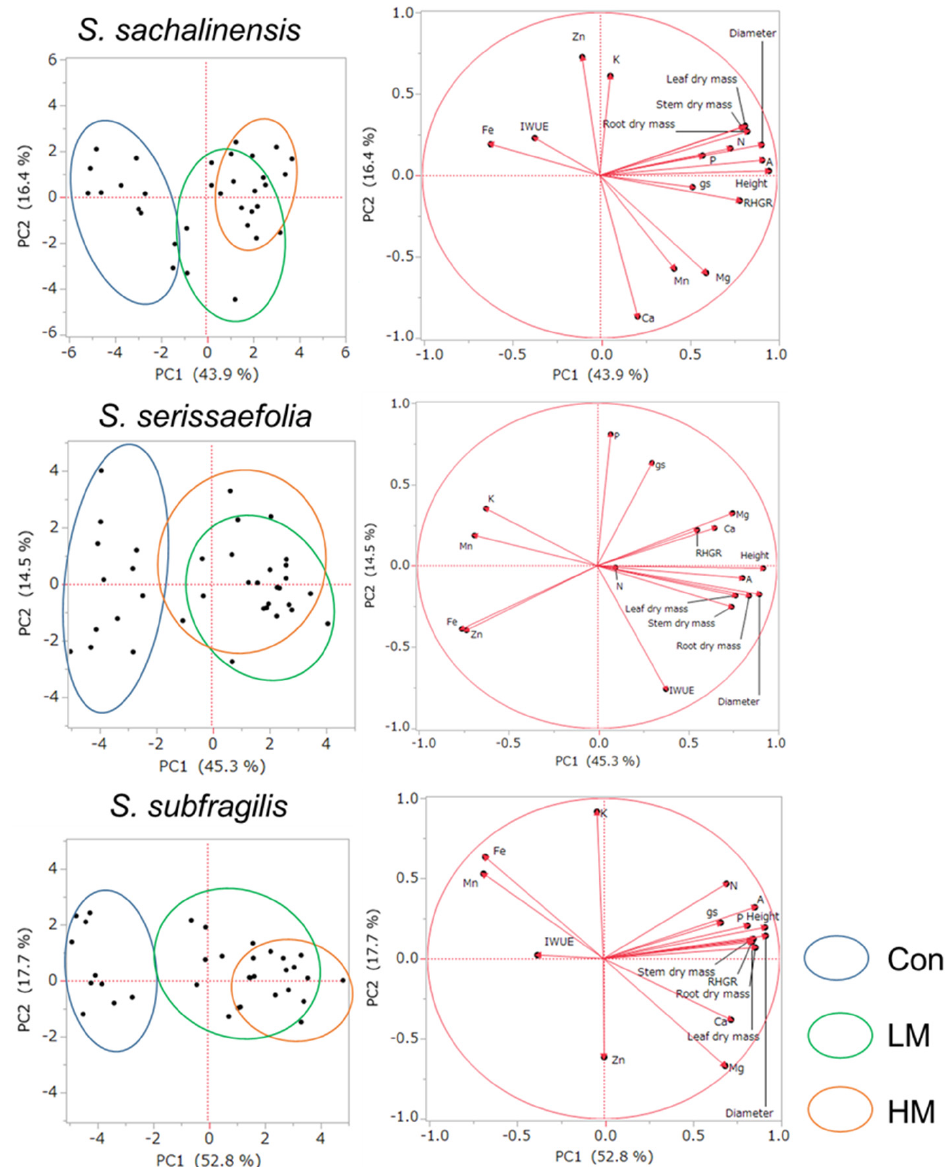
Figure 8. Principal component analysis (PCA) on the six parameters of physiological and growth characteristics (height, diameter, RHGR, leaf, stem and branch, and root dry masses), three parameters of physiological characteristics ( A , gs, and IWUE), and eight parameters of element concentrations in leaves (N, P, K, Ca, Mg, Mn, Fe, and Zn). For each figure of seven willows, the right side of the figure shows the position of loading vectors relative to PC1 and PC2. The left side of the figure shows the observations of individuals placed on the plane spanned by the PC1 and PC2 components. The circles in blue, green, and orange in the left figure represent the ranges of distribution of individuals in Con, LM, and HM treatment groups, respectively.